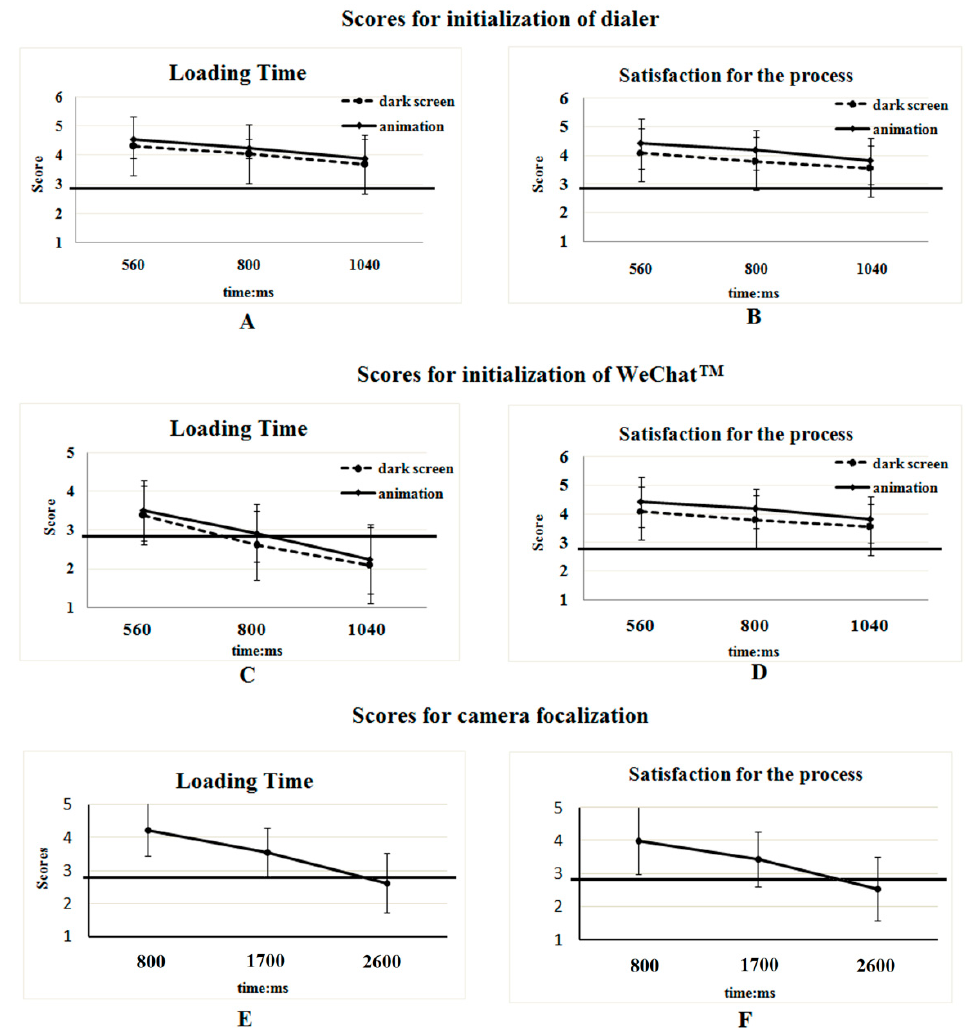
Figure 4. Scores for the loading time and the loading processes. ( A ) Loading time of initialization of dialer. ( B ) Satisfaction for the initialization of dialer. ( C ) Loading time of initialization of WeChat TM . ( D ) Satisfaction for the initialization of WeChat TM . ( E ) Loading time of camera focalization. ( F ) Satisfaction for camera focalization.